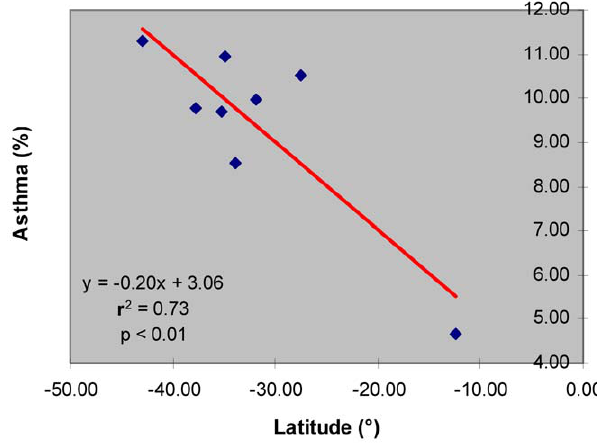
Figure 3. Asthma prevalence vs. latitude in the population of 8 major metropolitan areas of Australia.